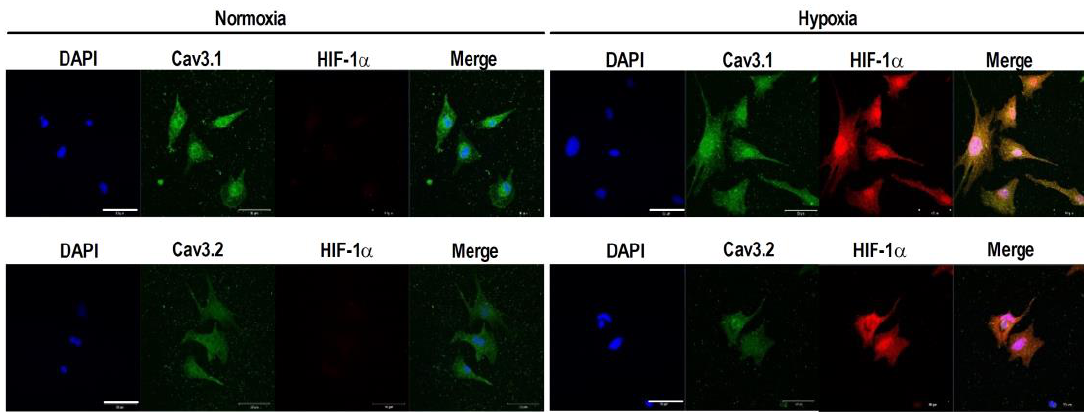
Figure 3. Immunocytochemistry staining for the detection of the Cav3 channels and the effect of hypoxic insult in cardiomyocytes. Cardiomyocytes were exposed to normoxia (21 % O 2 ) or hypoxia (1% O 2 ) for 3 h. Expression of Cav3.1 (green), Cav3.2 (green), and HIF-1 α (Red) are presented. Nuclei were counterstained with DAPI (blue). Scale bar = 20 μm.